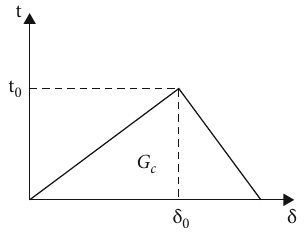
Figure 4: Cohesive traction-interaction failure